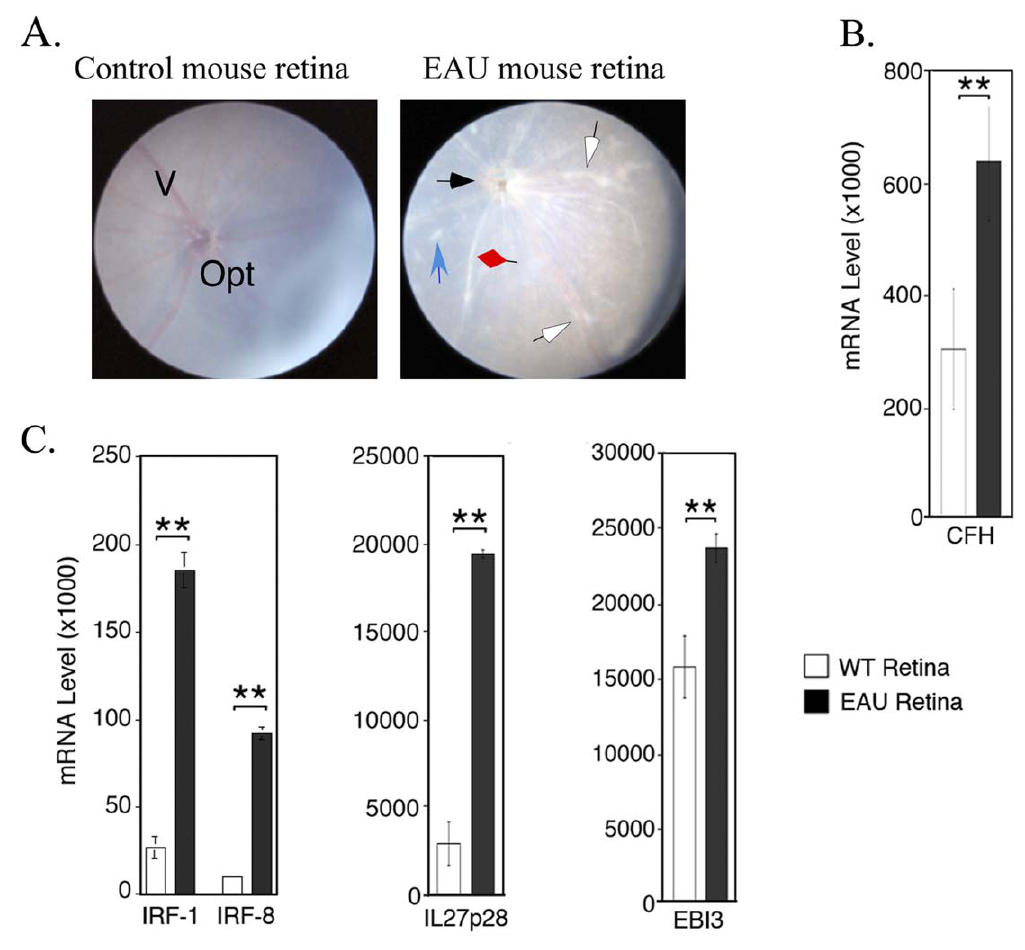
Figure 5. Expression of IRF-1, IRF-8 and IL-27 (IL27p28/EBi3) by retinal cells was up-regulated during experimental autoimmune uveitis (EAU). (A) Fundus images of the retina of un-immunized mouse and mouse with EAU. (B, C) Retinas were isolated from control or EAU mice and analyzed for IRF-1, IRF-8, CFH, IL27p28 or EBi3 expression by qRT-PCR.